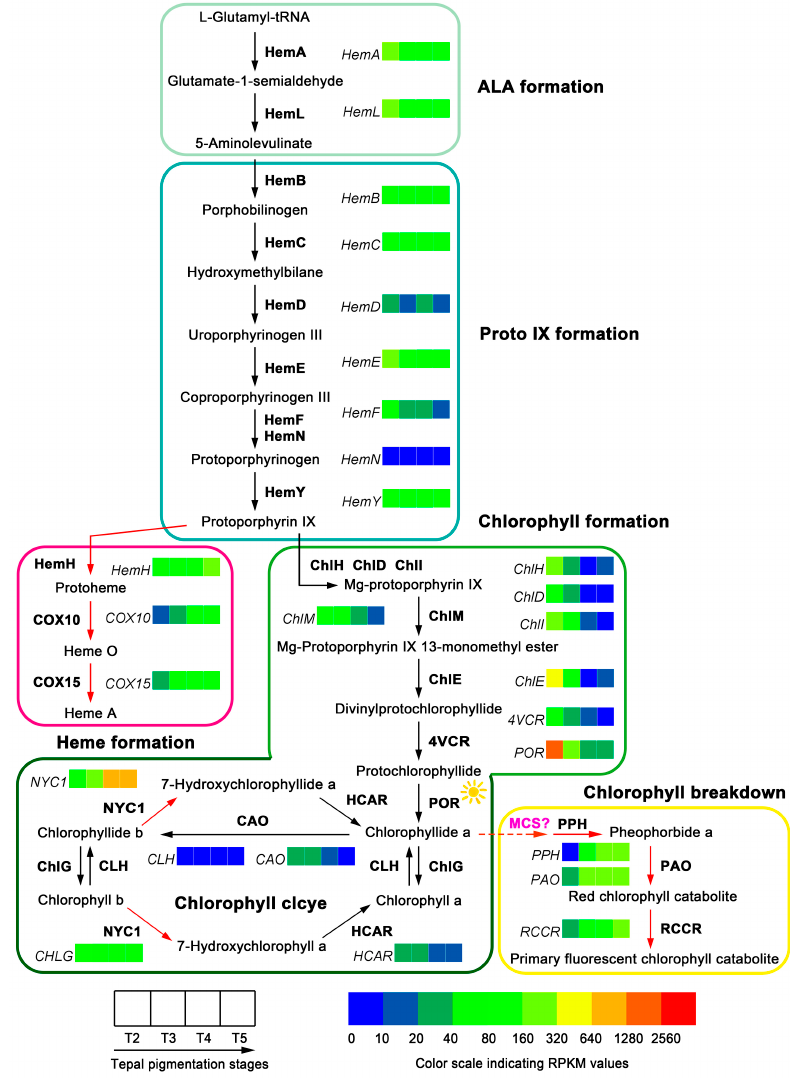
Figure 9. Chlorophyll metabolic pathway in tepals of Chinese narcissus and gene expression changes during tepal pigmentation process. The pathway is divided into five associated parts (ALA formation, Proto IX formation, heme formation, chlorophyll formation, and chlorophyll breakdown) based on the functions of unigenes. The additive expression changes of unigenes at different tepal pigmentation stages (T2, T3, T4 and T5) are shown by color grids based on RPKM value. Black filled arrows indicate the substance metabolism directions; red filled arrows indicate two dominant flux of chlorophyll metabolic pathway in tepals. Enzymes marked with sunlight indicate their catalytic activities can be influenced by light. Interaction of HCAR with other components in chlorophyll metabolic pathway has not been investigated, the molecular nature of MCS is unknown, thus are labeled with a question mark.